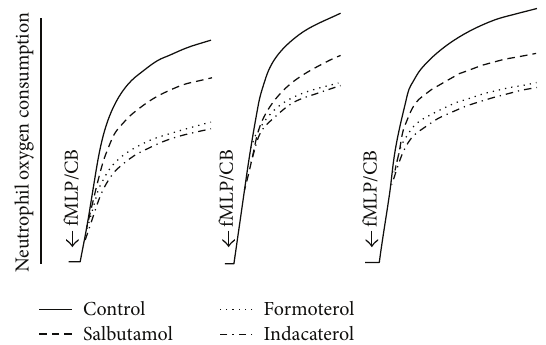
Figure 2: Typical traces from 3 separate experiments ( 𝑛 = 3 ) showing the effects of formoterol, indacaterol, and salbu- tamol at 100 nM on the magnitude of oxygen consumption by neutrophils activated with N-formyl-L-methionyl-L-leucyl-L- phenylalanine (1 𝜇 M)/cytochalasin B (1 𝜇 M)